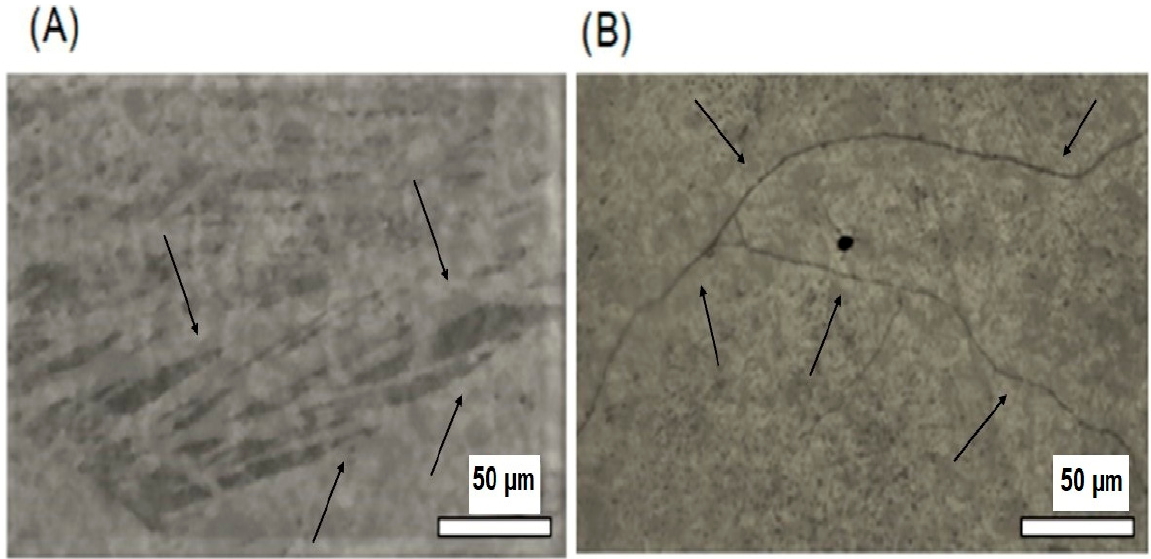
Figure 2. Microphotographs of OG ( A ) and OG + HA ( B ). Magnification at 50×.